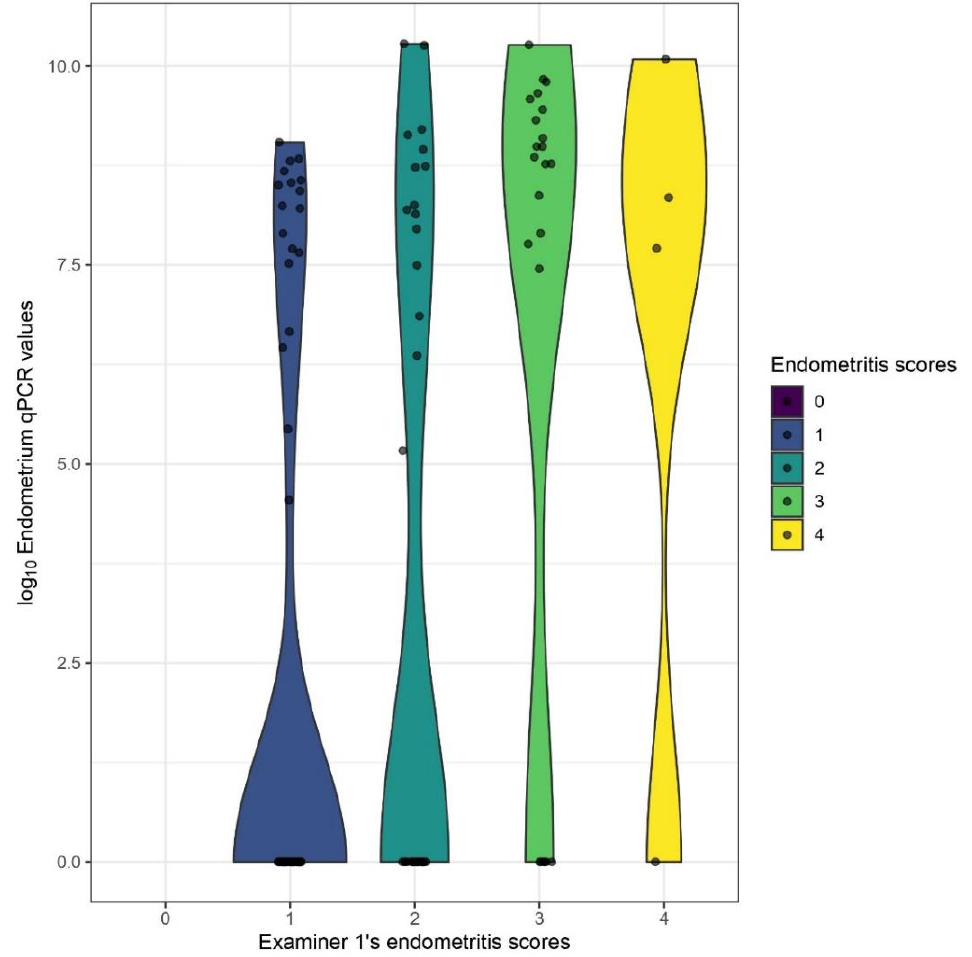
Figure 6. Violin plots depicting the distributional differences of log10 endometrial qPCR values between different endometritis grades as evaluated by examiner1.